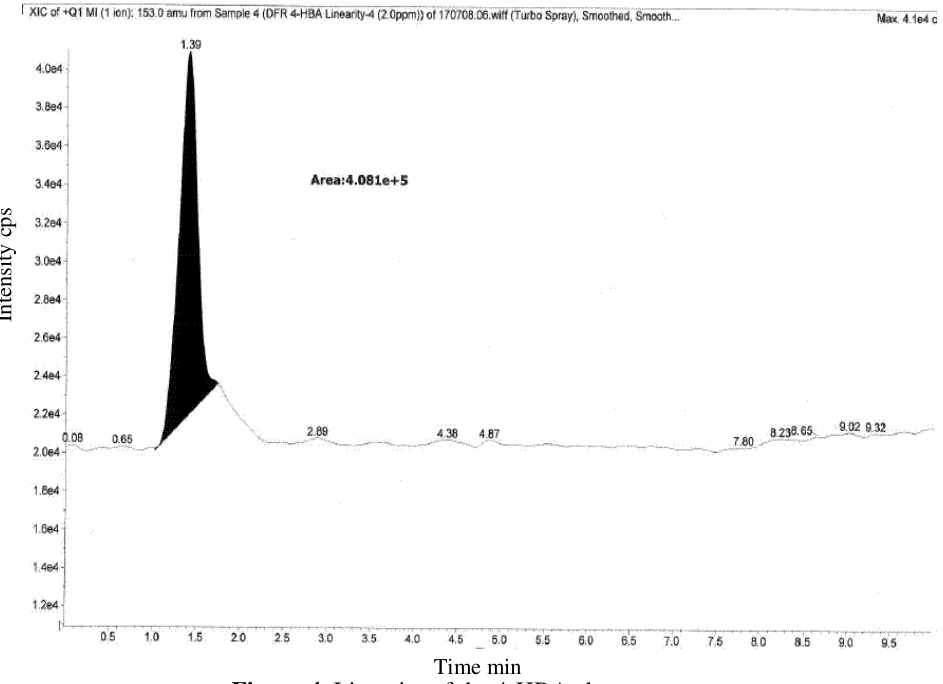
Figure 4. Linearity of the 4-HBA